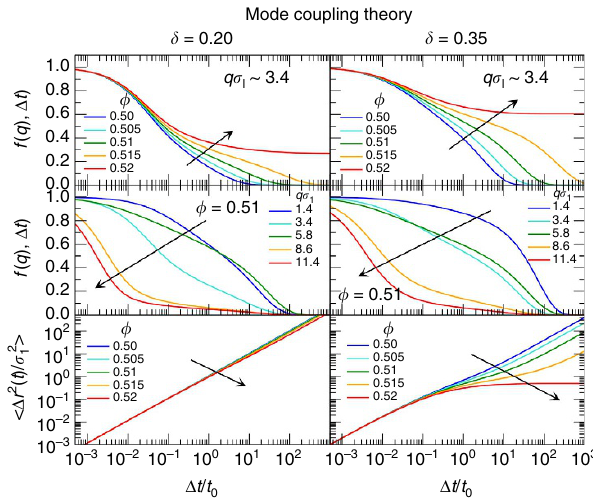
Figure 3 | Dynamics of the intruders as predicted by MCT. Intermediate scattering functions f ( q , D t ) (top, middle) and mean-squared displacements D r 2 = s 2 1 (cid:2) (cid:3) (bottom) describing the dynamics of small spheres in binary mixtures with size ratios delta below (left) and around (right) the onset of anomalous dynamics, for different magnitudes of the scattering vector q and total volume fraction f (as indicated). Arrows indicate increasing f or increasing q obtained from MCT shows the qualitative signatures found in simulations: for d ¼ 0.20 o d c , the long-time diffusion barely slows down with increasing f , indicating a partially frozen glass in which the small particles are mobile. For d ¼ 0.35 E d c , anomalous sub-diffusion is observed, indicating that the glass-transition of the large particles and the localization transition of the small particles are close to each other. Thus, the appearance of approximately logarithmic decay in Fig. 3 could be a signal of the transition from coupled dynamics of the two species at large d to decoupled dynamics at small d .